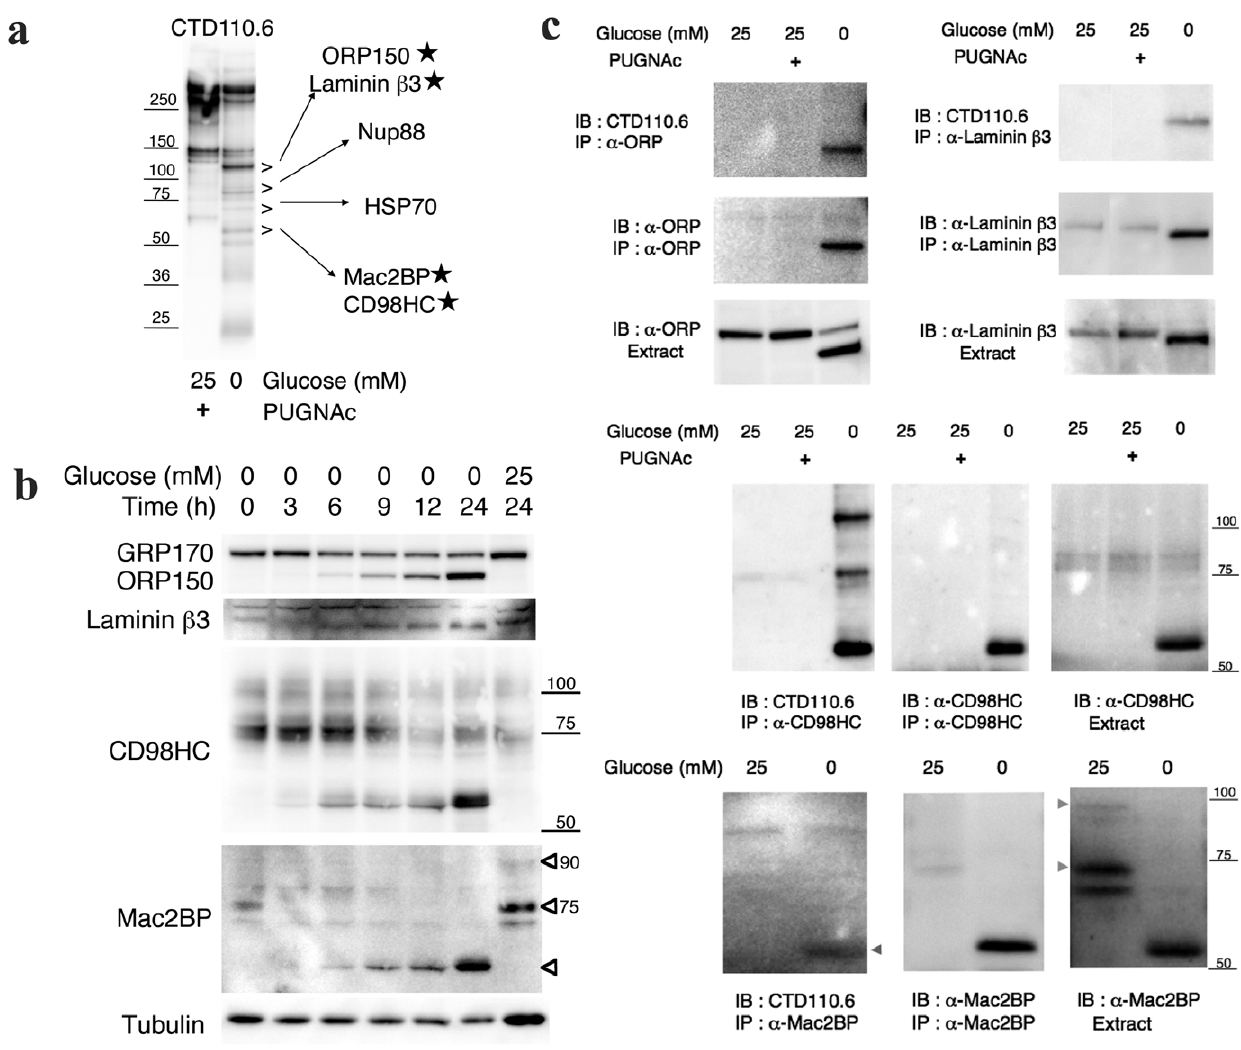
Figure 2. The identification and validation of proteins induced under glucose deprivation that reacted with CTD110.6 antibodies. a , The induced proteins were detected by CTD110.6 antibody. The . marks indicate the area excised for LC/MS/MS. The identified proteins are indicated. b , An immunoblot showing the four proteins induced by glucose deprivation. The incubation times for in high-glucose medium (25 mM glucose) or in glucose deprivation medium (0 mM glucose) are indicated. An anti- a -tubulin antibody was used as an internal control. c , Immunoblots showing immunoprecipitation samples of the four induced proteins.